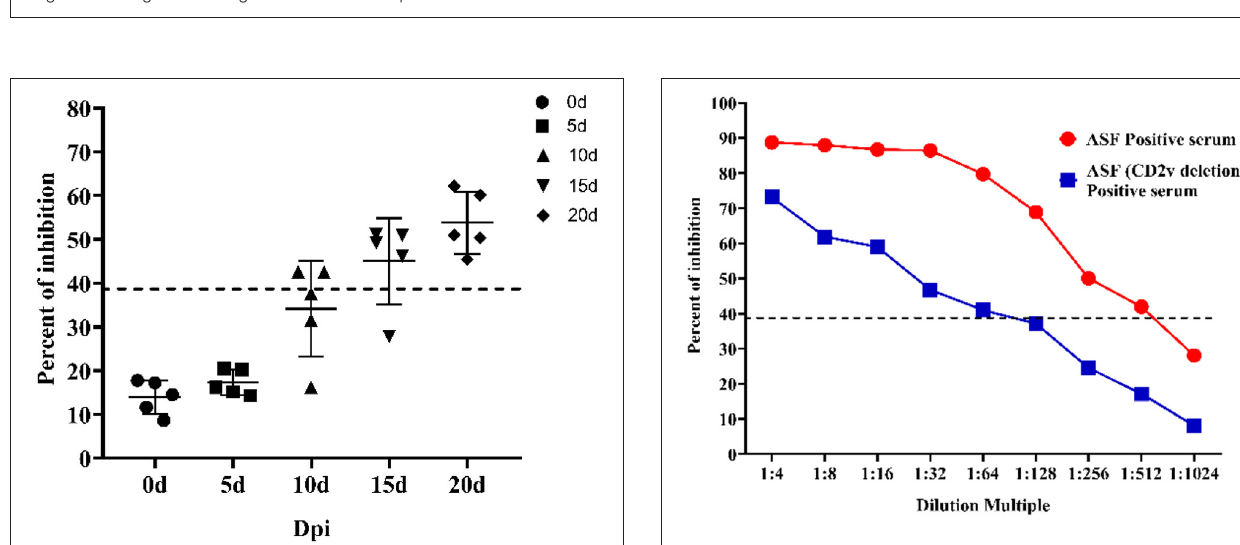
FIGURE 4 | ASFV p30-based blocking ELISA analysis of serum samples. The analysis was performed on known ASFV-negative samples ( n = 88) and known ASFV-positive samples ( n = 98). (A) ROC analysis of blocking ELISA results while the area under the curve (AUC) of the test was 0.997. (B) Interactive dot plot diagram showing the blocking value of serum samples while the cut-off value was set to 38.38%.